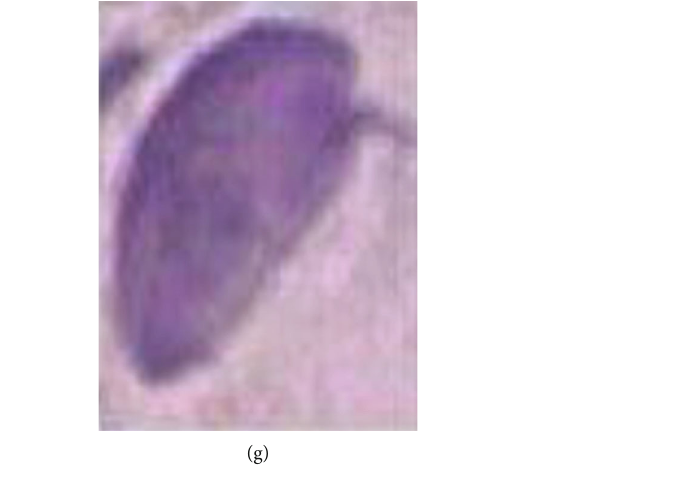
Figure 1: [24, 25] Pap smear image: (a) preliminary squamous, (b) intermediate, (c) columnar squamous, (d) Preliminary dysplasia, (e) moderate, (f) severe, and (g)